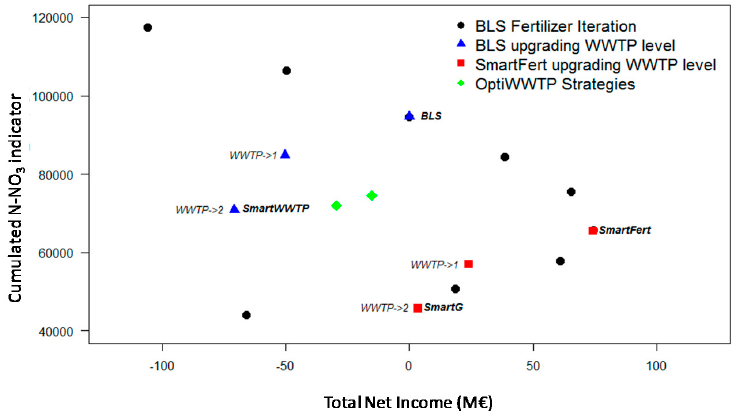
Figure 5. Comparison between economic (total net income, Equation (4)) and environmental objective (N ‐ NO 3 indicator based on Equation (2)) for iterative simulations. Black dots indicate the strategy of varying the fertilization rate by the same amount in all HRUs. Blue triangles show the strategy of upgrading all WWTPs for the BLS. Red squares show the same strategies applied to the best fertilization strategy (SmartFert). Note that both BLS and SmartFert points are at current WWTP status; WWTP => 1: all the plants are upgraded to CN level; WWTP => 2: all plants are upgraded to CNDP level. Table 6. Environmental and economic indicator for some of the catchment management strategies tested in the Upper Danube case study.